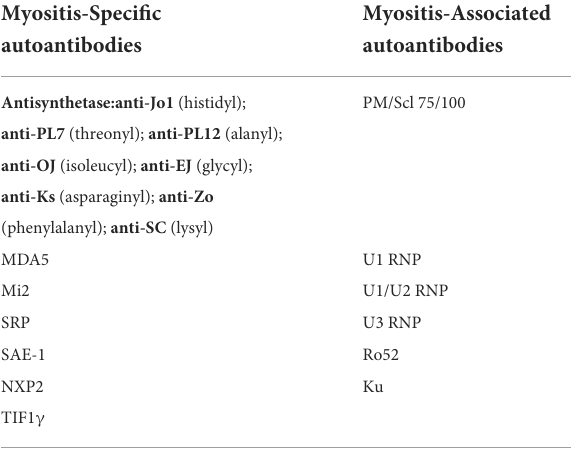
TABLE 1 Myositis-specific and myositis-associated autoantibodies; the antisynthetase syndrome associated antibodies are in bold with each specific target aminoacyl tRNA synthetase enzyme in